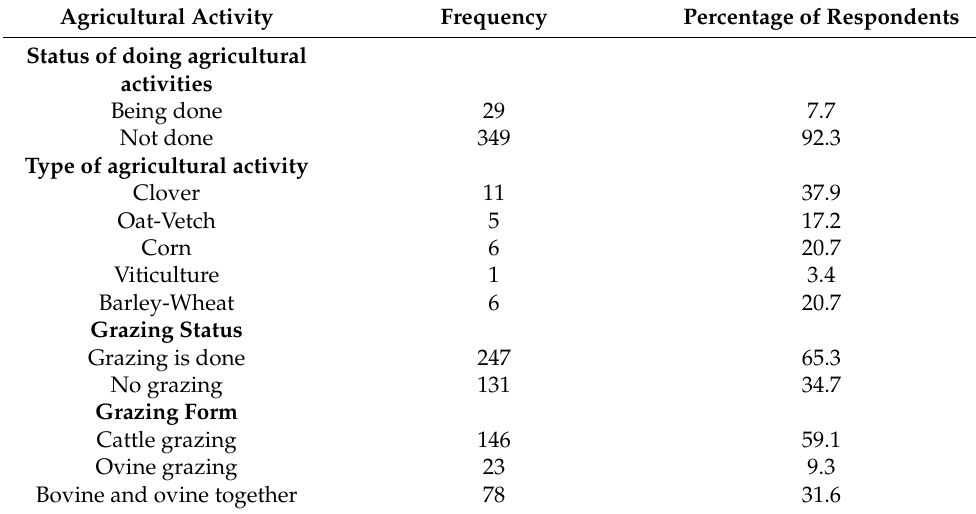
Table 6. Agro-silvopastoral systems practices under stone pine.